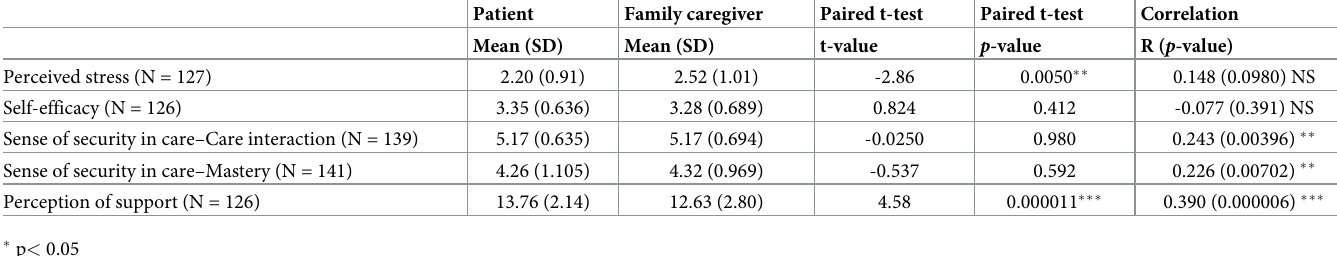
Table 3. Patient and family caregiver scores on test variables including paired t-tests and